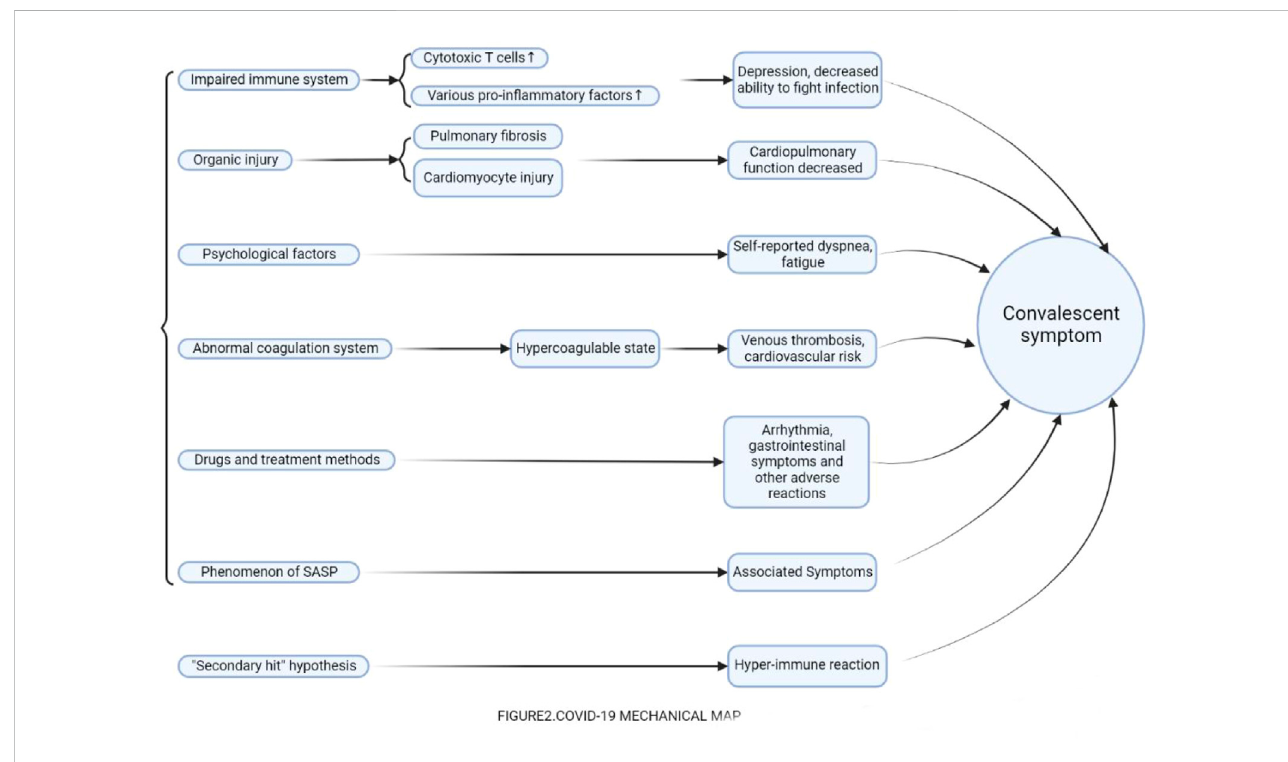
FIGURE 2 COVID-19 Mechanical